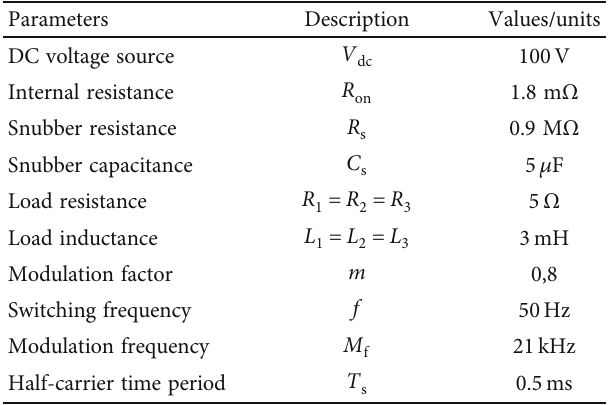
Table 3: The parameters and simulation